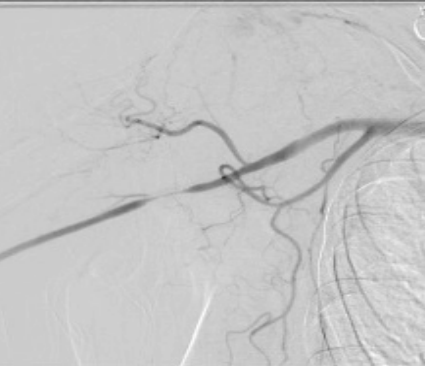
Figure 3: Tapered high grade stenosis of the proximal right brachial artery with collateral muscular branches.